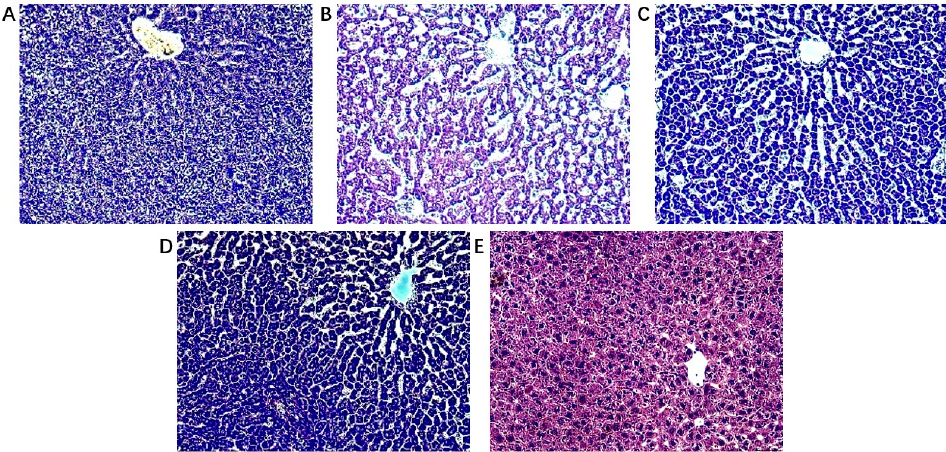
Figure 2. Histopathological observation ( A ) Control group; ( B ) Model group; ( C ) A. japonica low dose group; ( D ) A. japonica high dose group; and ( E ) Positive control group (Bifendate, BFD). Scale bar = 200 μ m.